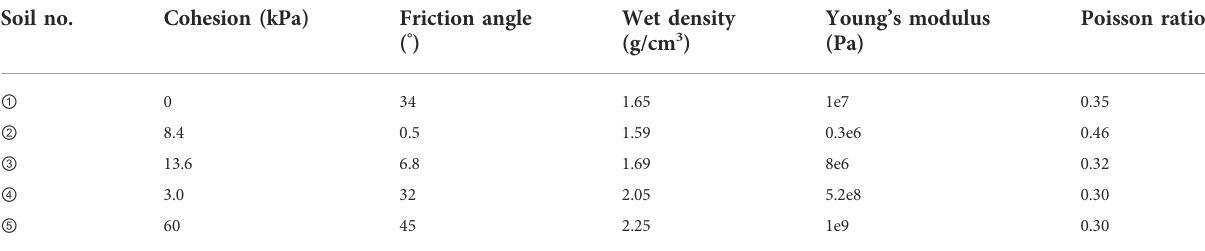
TABLE 2 Physical and mechanical properties of the soil. Soil